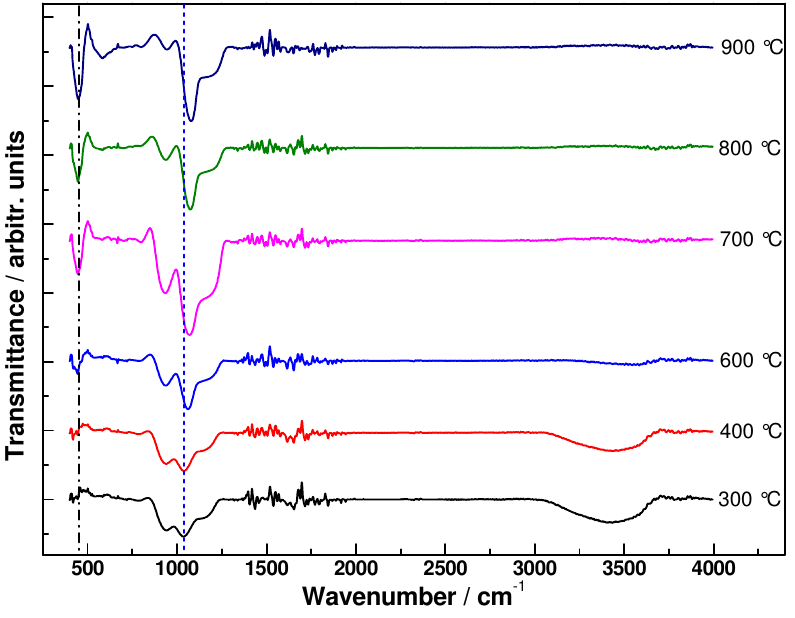
Figure 3. Schematic diagram of TiO